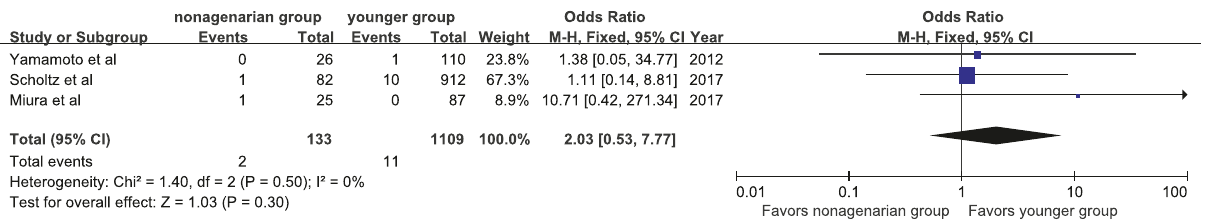
Figure 12: Forest plot of pooled analysis comparing the rates of conversion to aortic valve replacement in nonagenarians versus younger